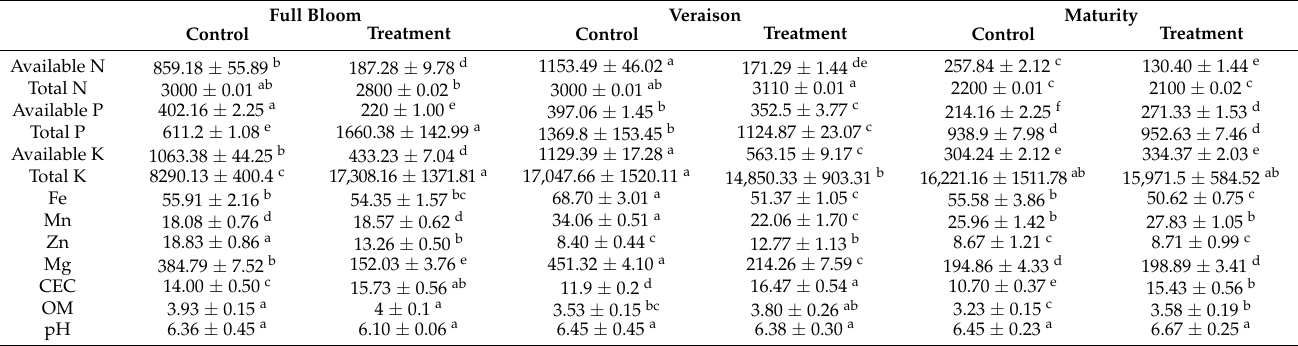
Table 2. Change in soil properties at successional developmental stages of control and treated plants. Full Bloom Veraison